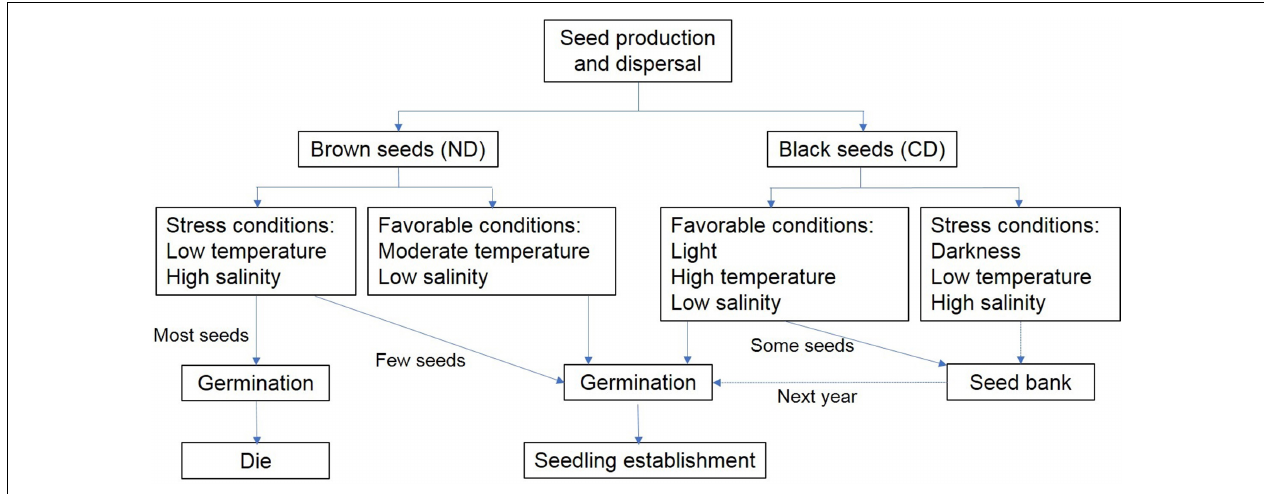
FIGURE 8 | Conceptual model of dynamics of germination and seedling growth of dimorphic seeds of S. salsa